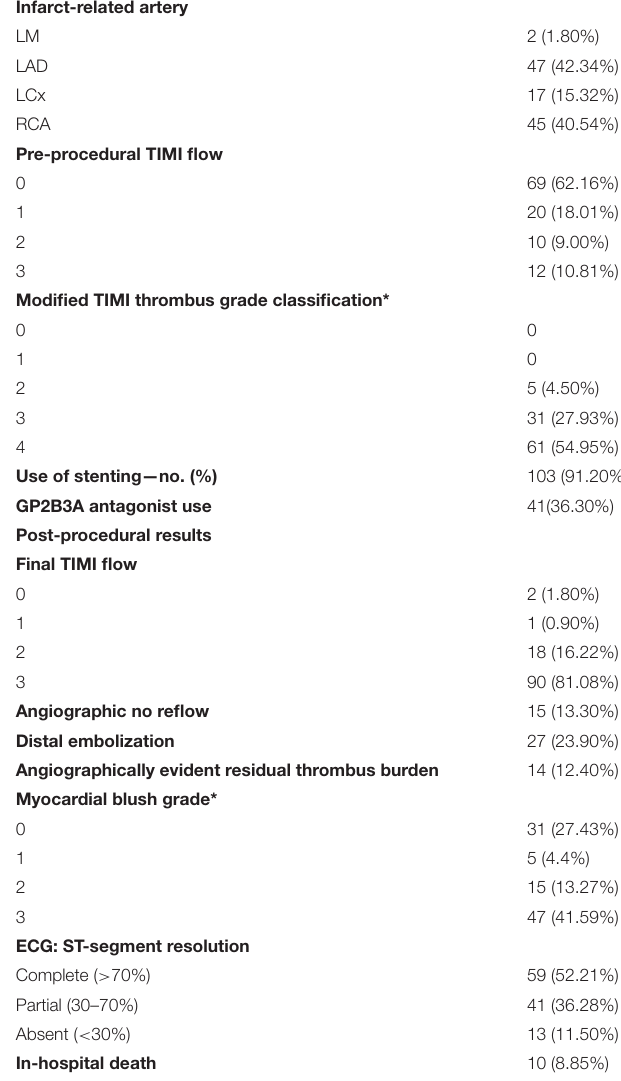
TABLE 3 | Percutaneous coronary intervention procedure details and angiographic outcomes. Infarct-related